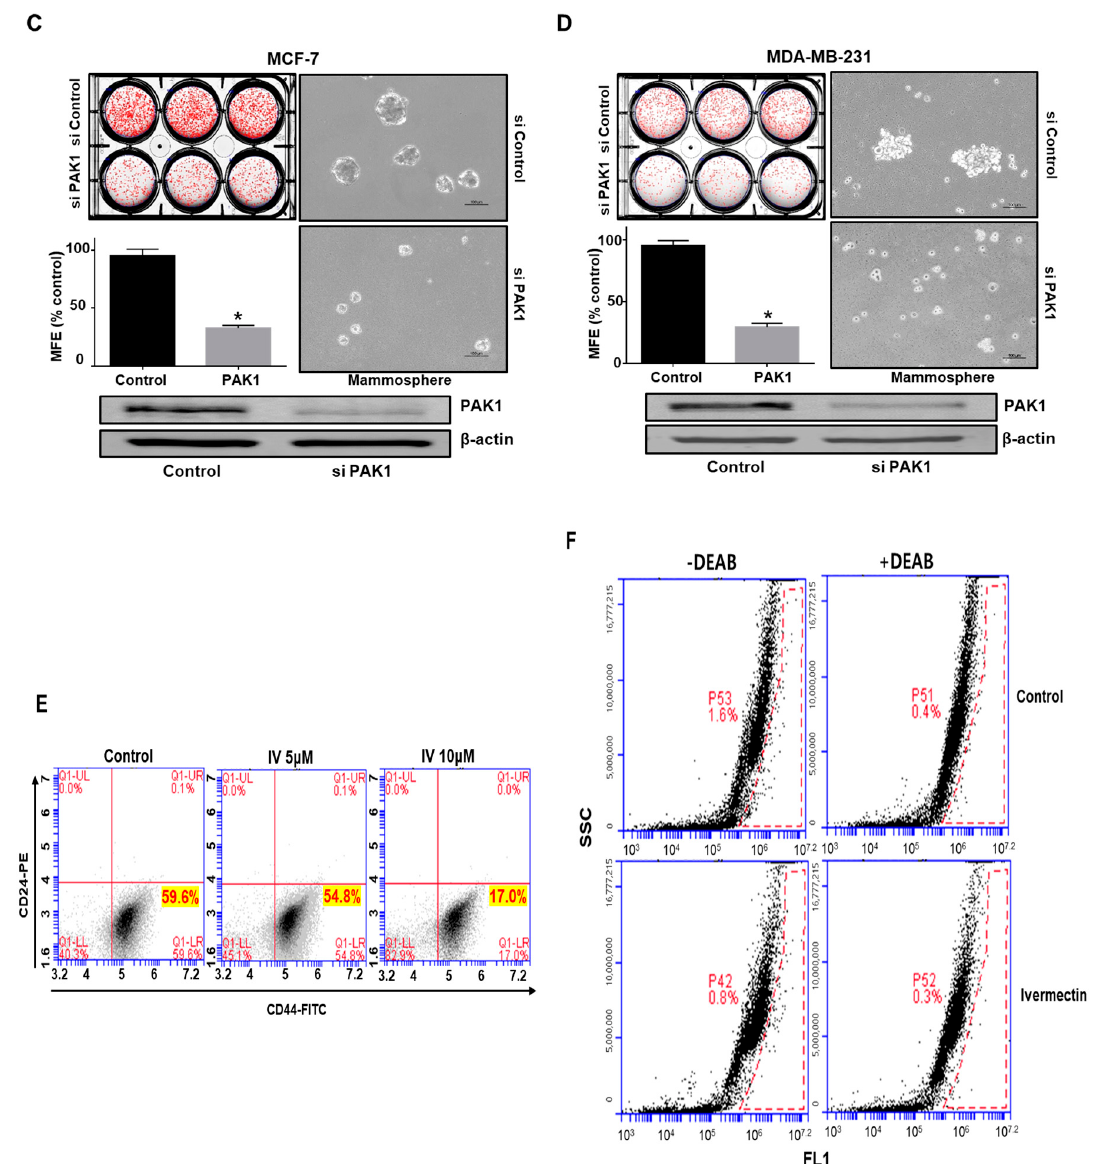
Figure 3. PAK1 induces mammosphere formation and regulates hallmark breast CSC processes. The PAK1 inhibitor IPA-3 and the PAK1 inactivator ivermectin were included in mammosphere induction cultures for one week. ( A , B ) The e ff ect of IPA-3 and ivermectin on mammosphere formation. Primary mammospheres were treated with IPA-3 (10 and 20 µ M) or ivermectin (2.5 and 5 µ M). Images were captured by microscopy. ( C , D ) E ff ect of PAK1 on mammosphere formation assessed using PAK1 siRNA. PAK1-silenced cells were seeded in ultralow plates and cultured for seven days. Images were captured by microscopy at 10 × magnification. The data are presented as the mean ± SD; n = 3; * p < 0.05 vs. control. ( E ) E ff ect of ivermectin, which inactivates PAK1, on the breast CSC hallmark CD44 + / CD24 − -positive cell population. The ivermectin (5 µ M)-treated CD44 + / CD24 − -cell population was analyzed by flow cytometry. Ten thousand cells were collected. Gating was based on binding of the control antibody (red cross). ( F ) E ff ect of ivermectin on ALDH-positive cells. The breast cancer cells were analyzed using an ALDEFLUOR assay. The right panel shows ALDH-positive cancer cells with N, N-diethylaminobenzaldehyde (DEAB), and the left panel represents ALDH-positive cancer cells without DEAB. The ALDH-positive population was gated in a box (red dotted line box).